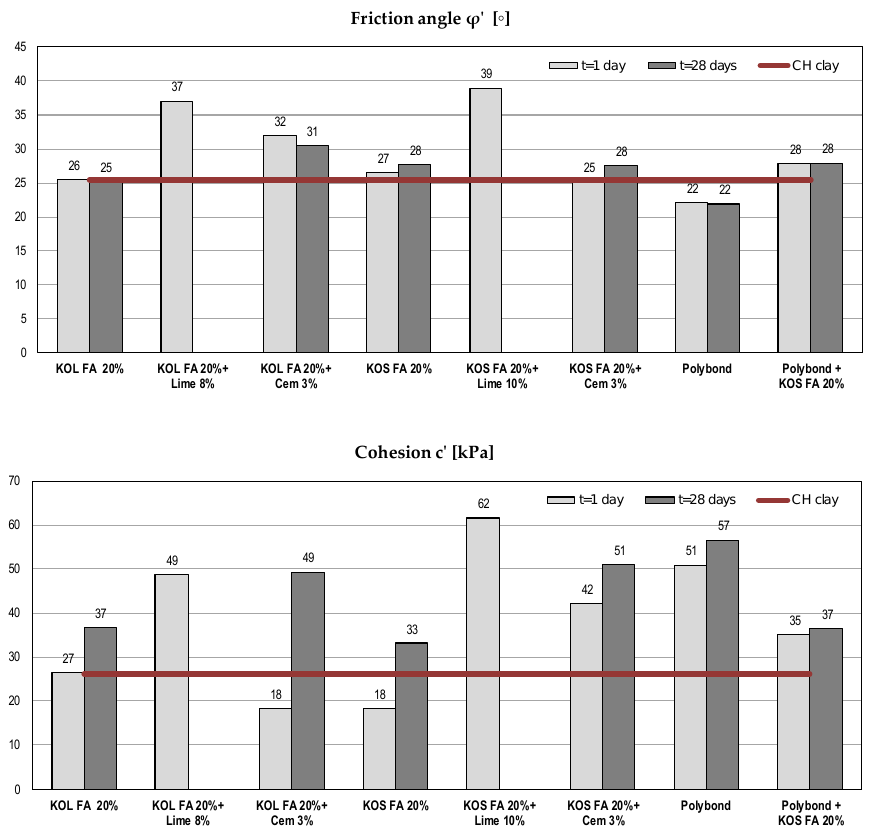
Figure 4. Shear strength parameters of different mixtures with CH clay.